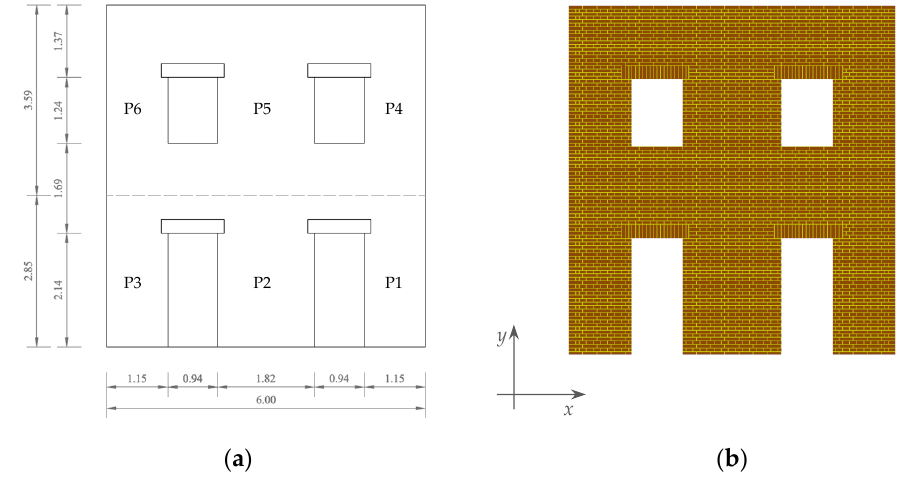
Figure 3 . Wall geometry: ( a ) element dimensions (m), numbering of masonry piers, and ( b ) layout of the numerical model.